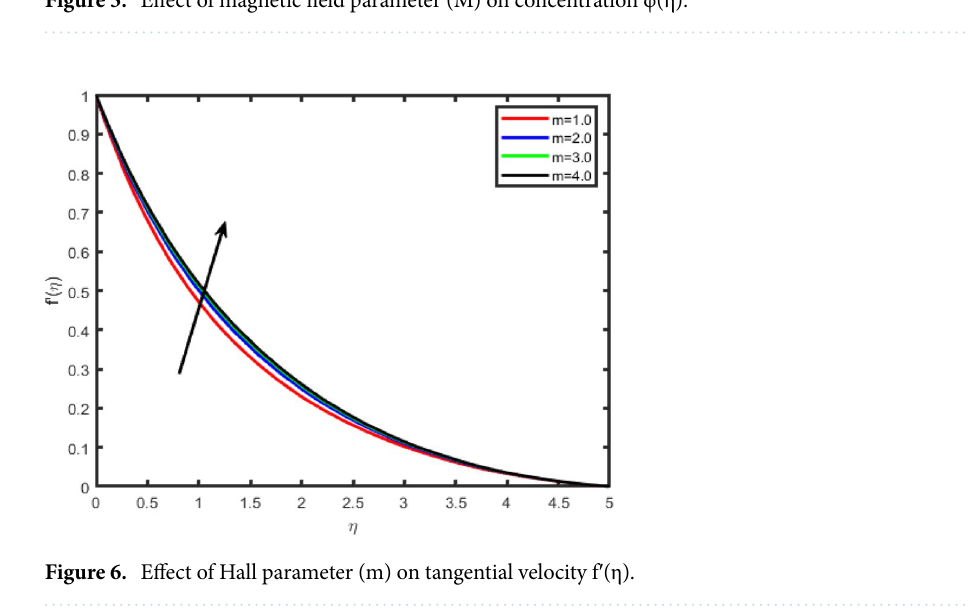
Figure 5. Effect of magnetic field parameter (M) on concentration ϕ(η).